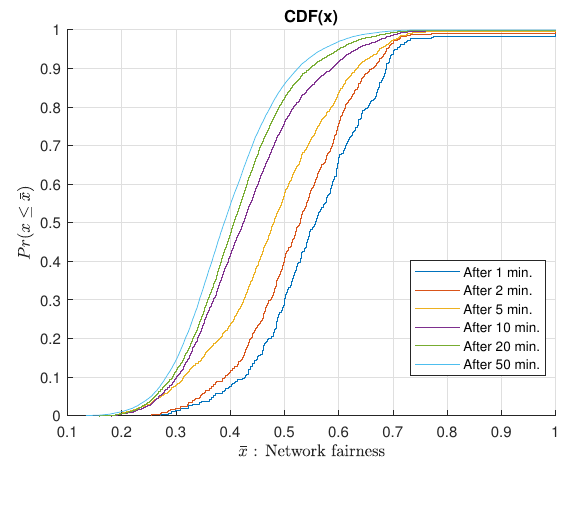
Figure 3. CDF of network